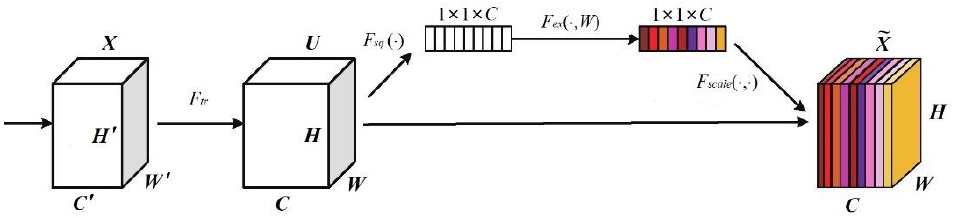
Figure 2. Basic structure of SENet.